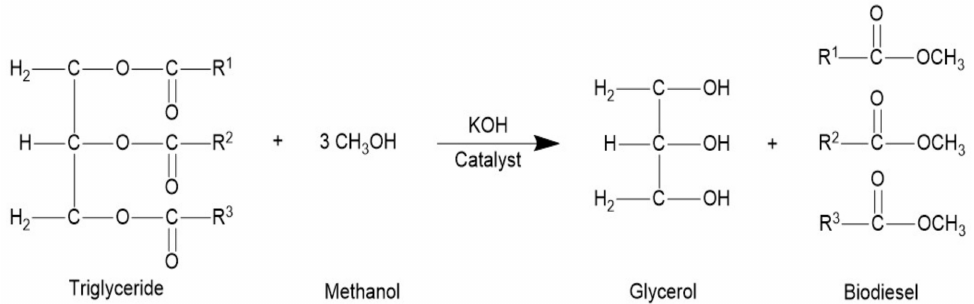
Figure 1. Transesterification of Koelreuteria paniculata oil to